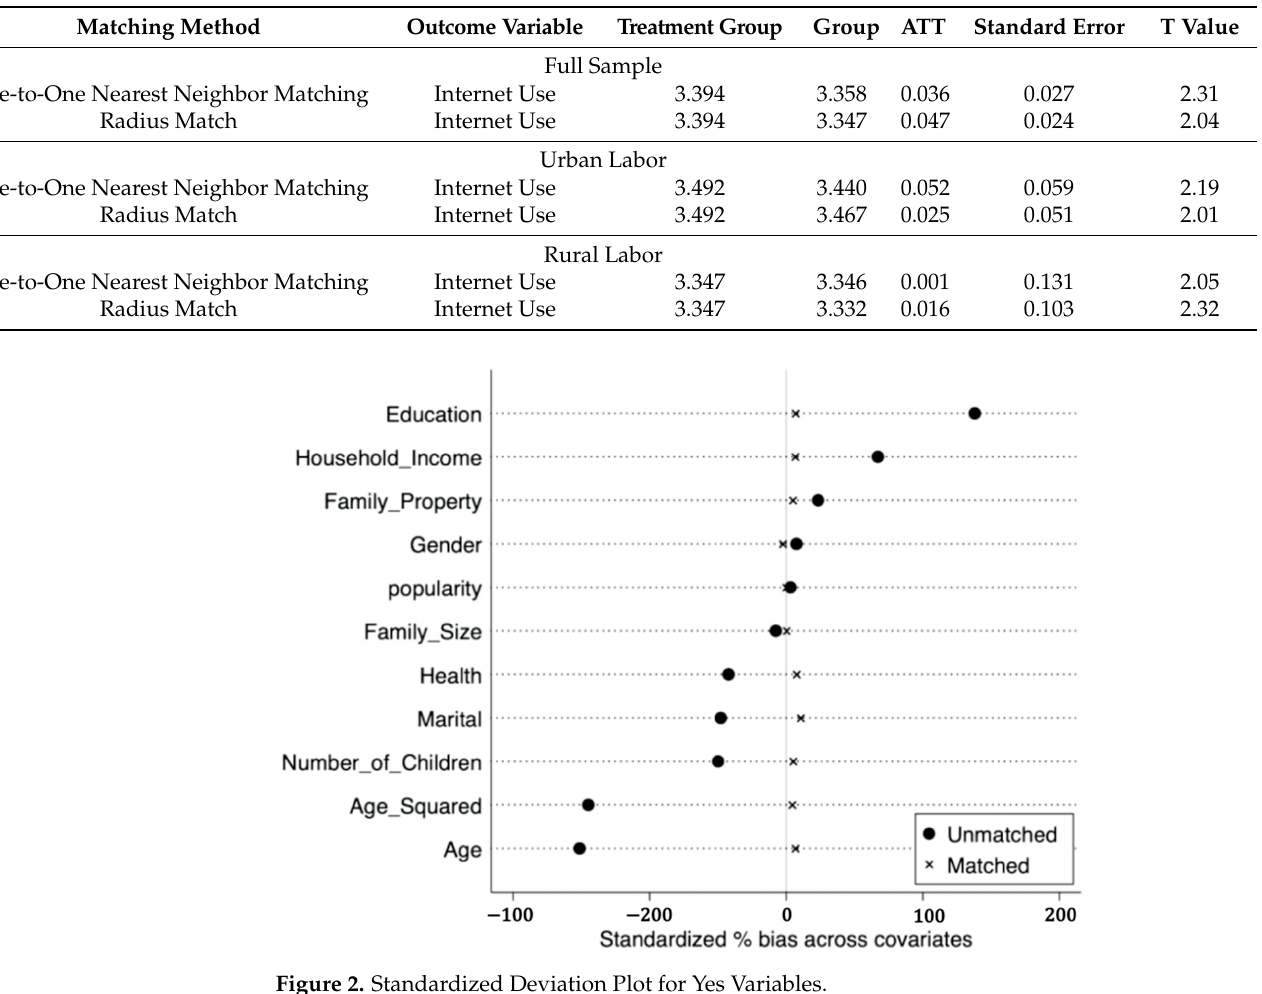
Table 7. Internet Use and Job Satisfaction: Propensity Score Matching Method.